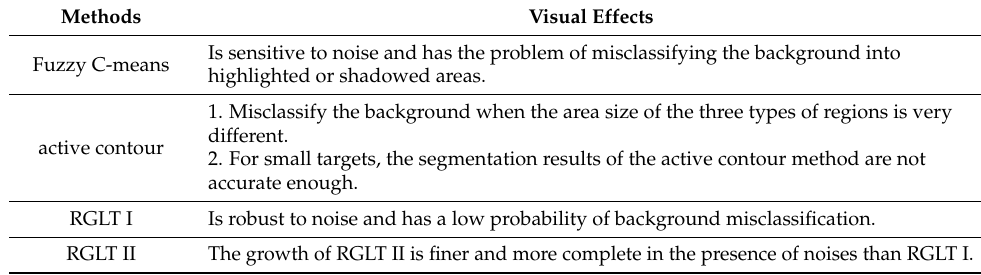
Table 4. Summary of the visual effects of the segmentation